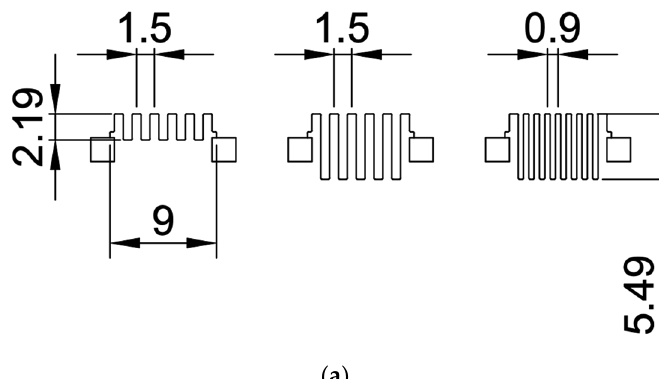
Figure 9. Normalized resistance vs. temperature of the silver sensor (66 mm long) and Pt100 sensor. R 0 is the resistance at 0 °C. Error bars correspond to the output range of eight different sensors.